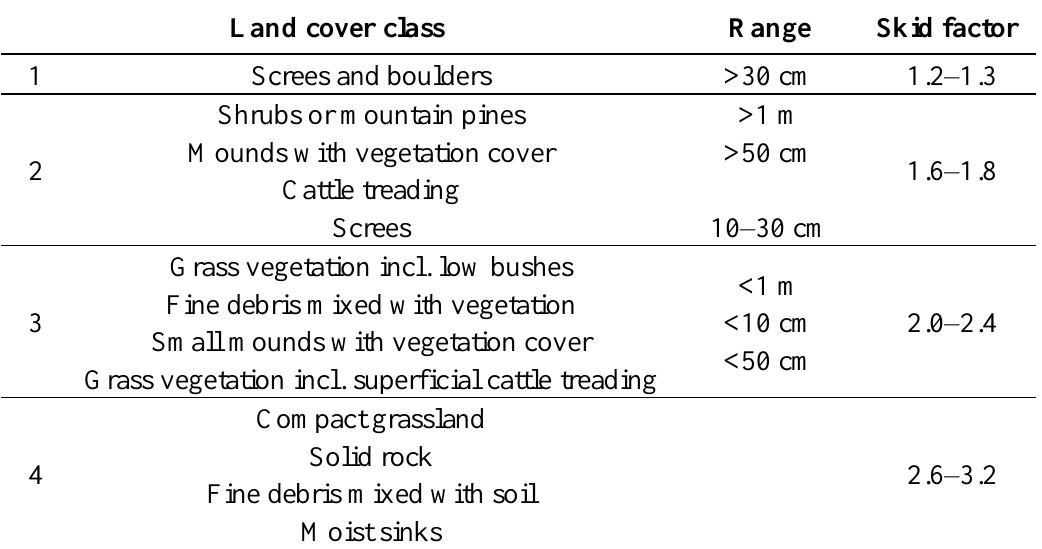
Table 1. Skid factors assigned to land cover types featuring varying roughness characteristics